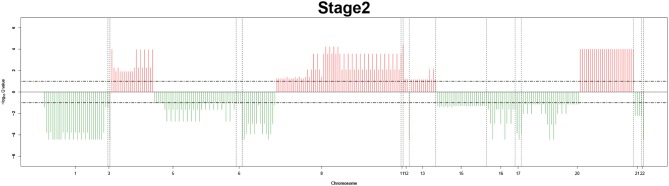
Recurrent genome-wide SCNAs in stage 2. Genome-wide amplifications (red blocks) and deletions (green blocks) in stage 2.